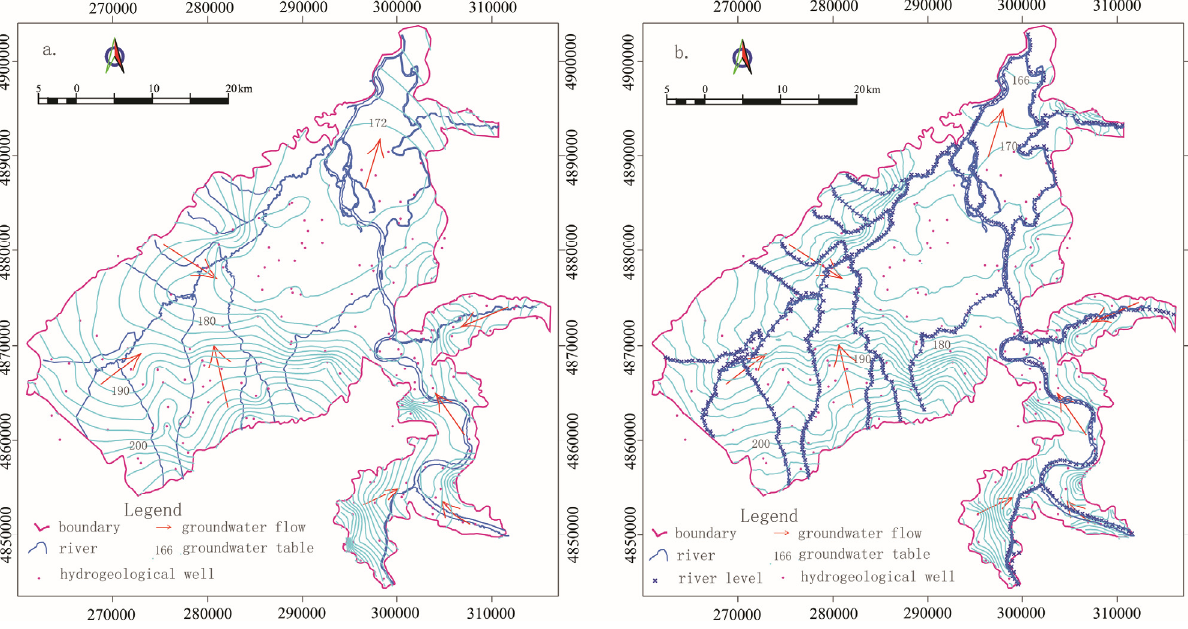
Figure 9. Groundwater level in JUA ( a ) interpolated just using the hydrogeological wells and ( b ) interpolated using the hydrogeological wells and the river